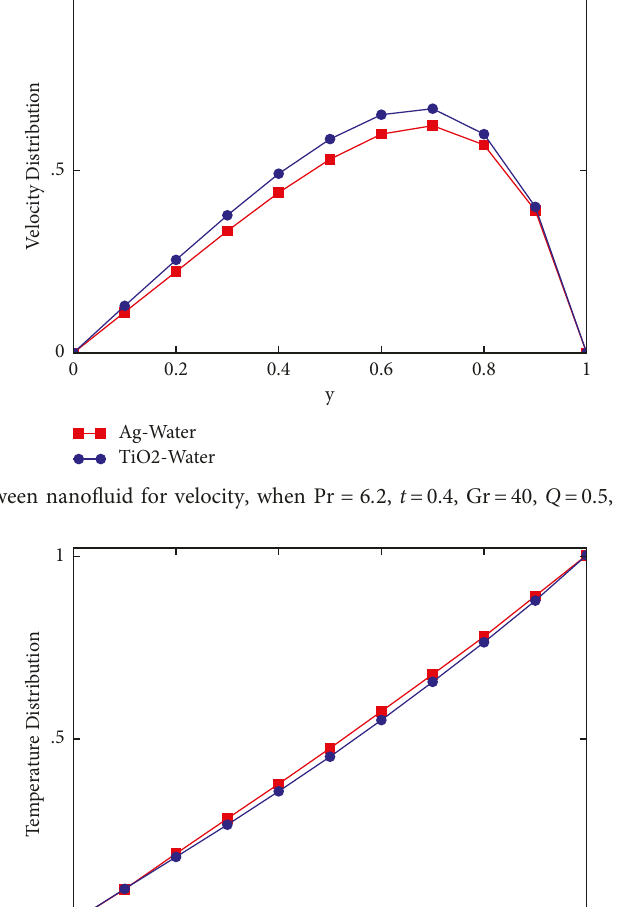
Figure 7: Correlation among nanofluids for temperature, when t